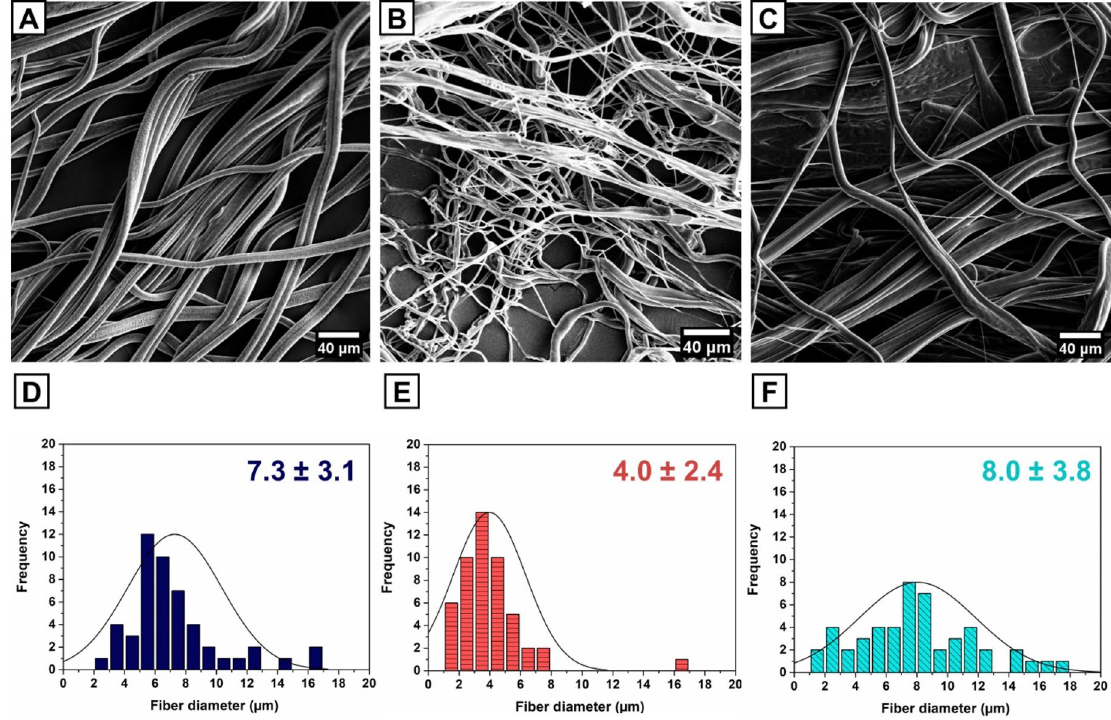
Figure 1. SEM images and fiber diameter distributions of PU ( A , D ), PU-Col-El ( B , E ), and PU-Gel ( C , F )